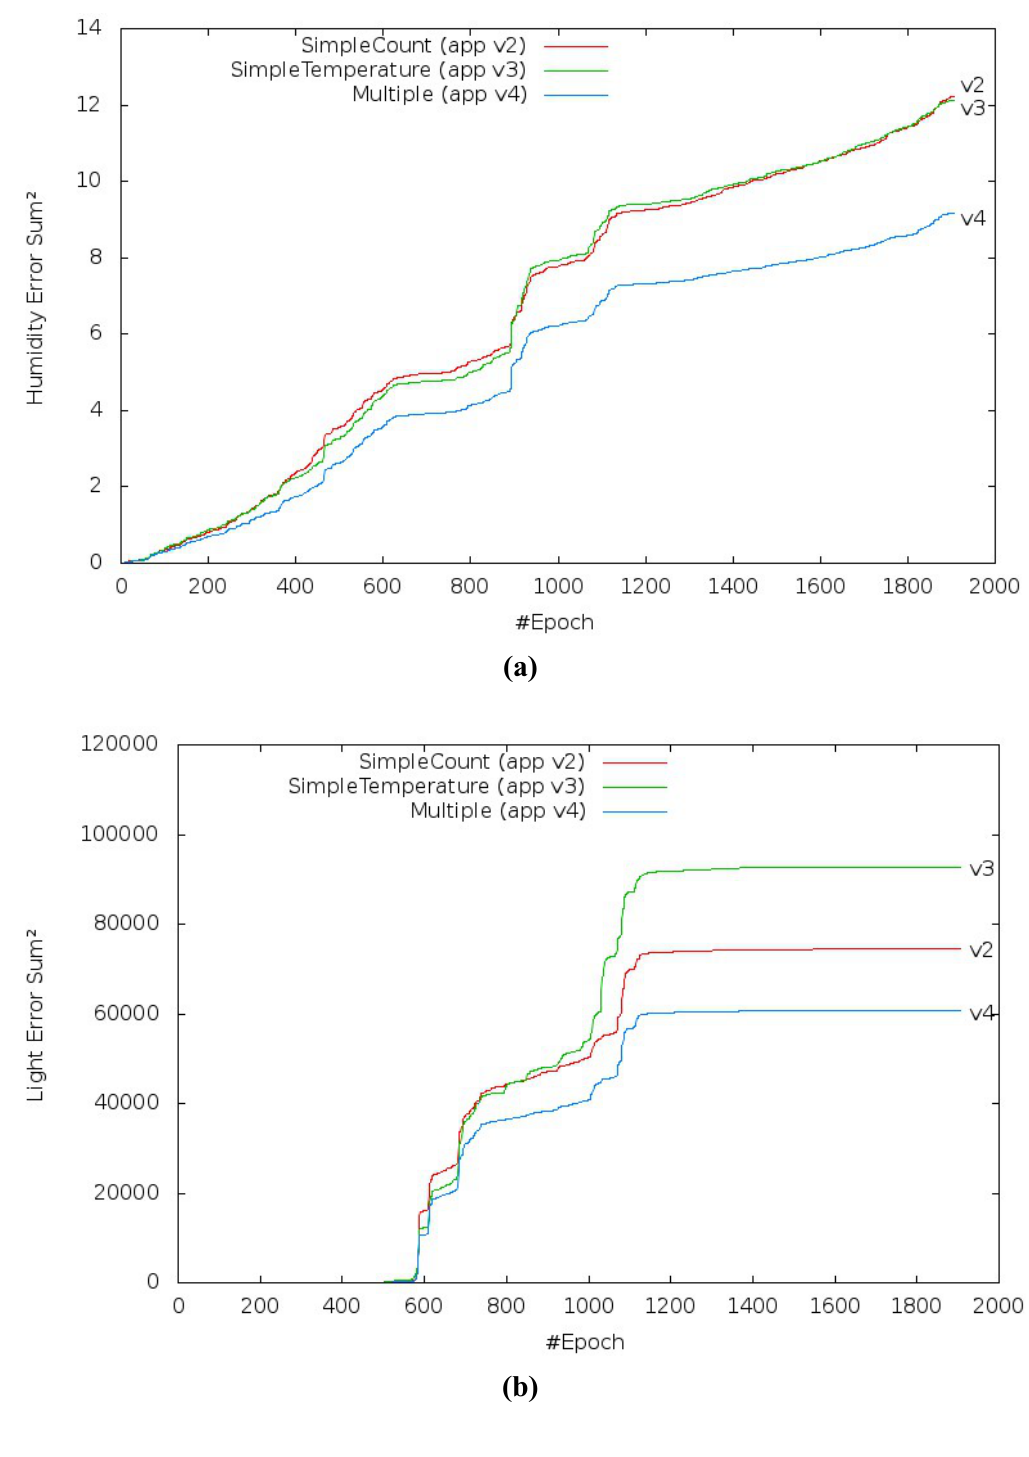
Figure 16. Performance evaluation of the prediction accuracy over one day from the trace to the application versions which use linear regression (app v2 to app v4): (a) Humidity error. (b) Light error. (c) Humidity improvement. (d) Light